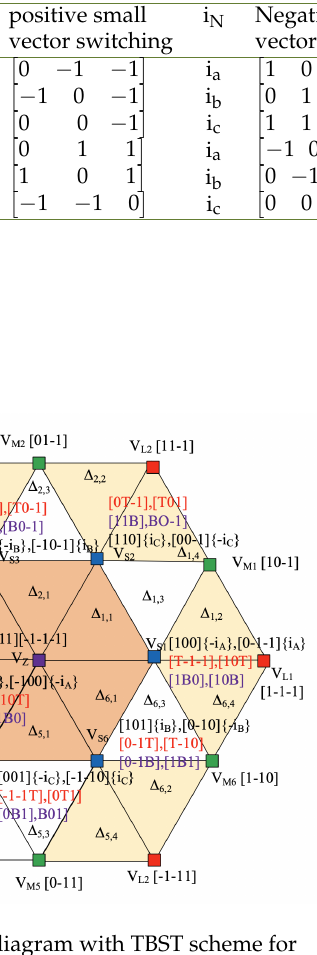
Fig. 3. space vector diagram with TBST scheme for